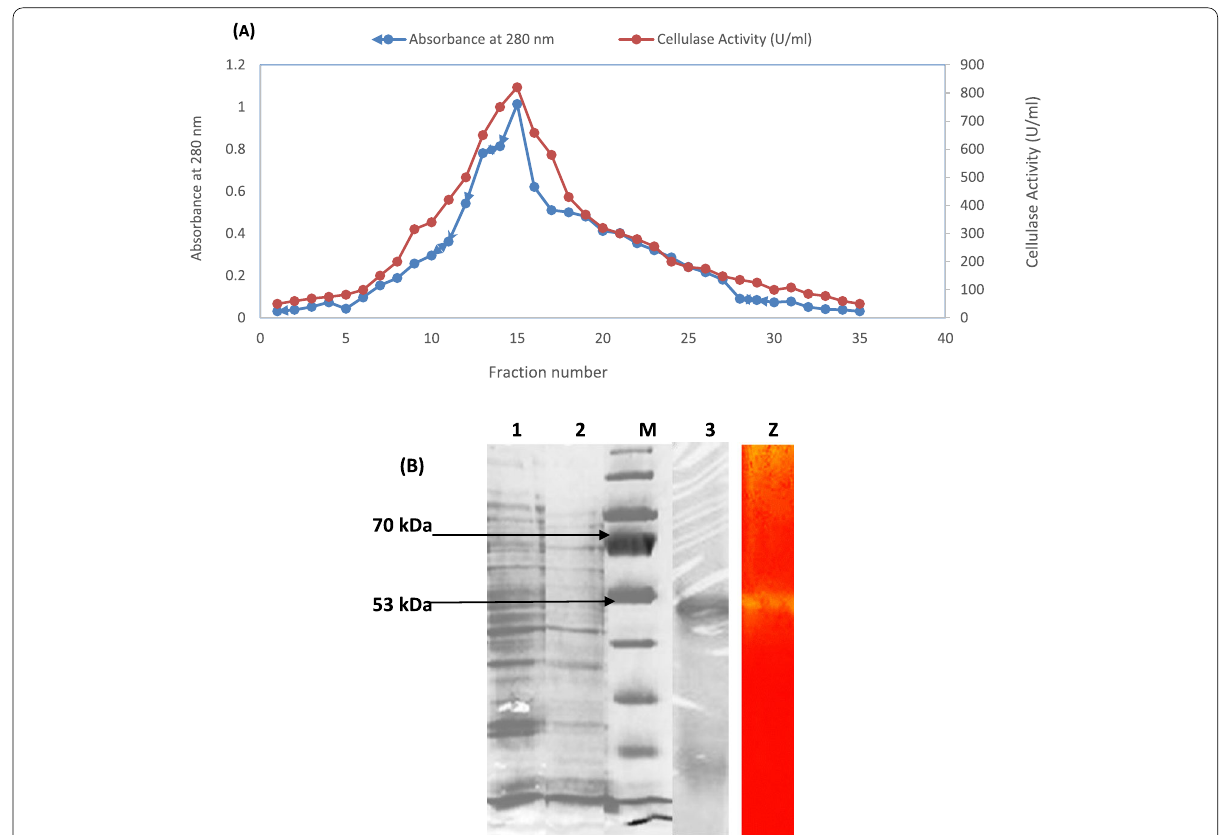
Fig. 2 A purification profile of cellulase cel9z from B. licheniformis Z9 by Sephadex. G‑100 column chromatography showing protein and enzyme activity. B SDS‑PAGE and Zymogram analysis of cellulase enzyme from B. licheniformis Z9. lane (M): GangNam‑STAIN ™ Prestained Protein Ladder (iNtRON Biotechnology) of 10–245 kDa range; lane (1) crude protein; lane (2): proteins precipitated at 40–80% saturation of ammonium sulfate; lane (3): purified enzyme from Sephadex G‑100 column; (Z)